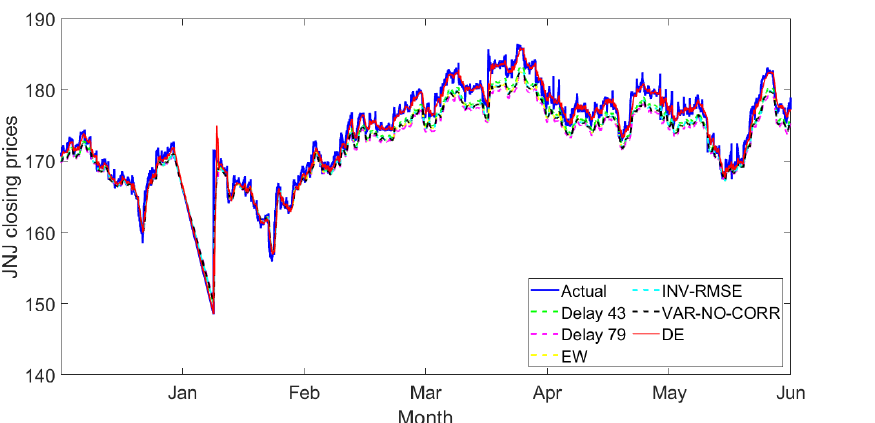
Figure 14. The forecasting curve for actual data versus the individual and combination methods of JNJ stock obtained from CNN model between January and June 2022.